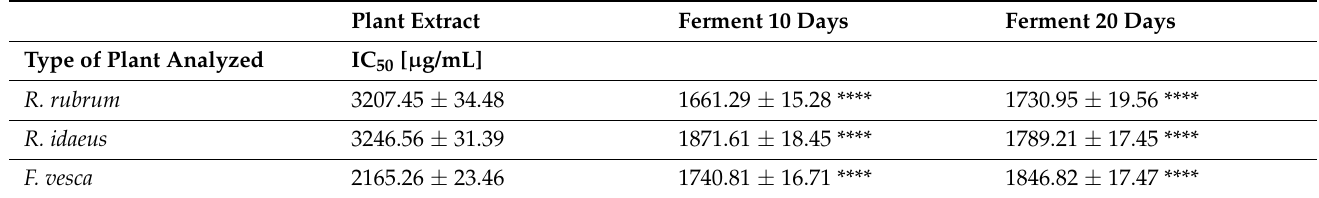
Table 3. Values of IC 50 of DPPH radical scavenging for R. rubrum , R. ideaus , and F. vesca extracts and kombucha ferments after 20 min of exposure. Values are means ± standard deviation (SD) of triplicate.